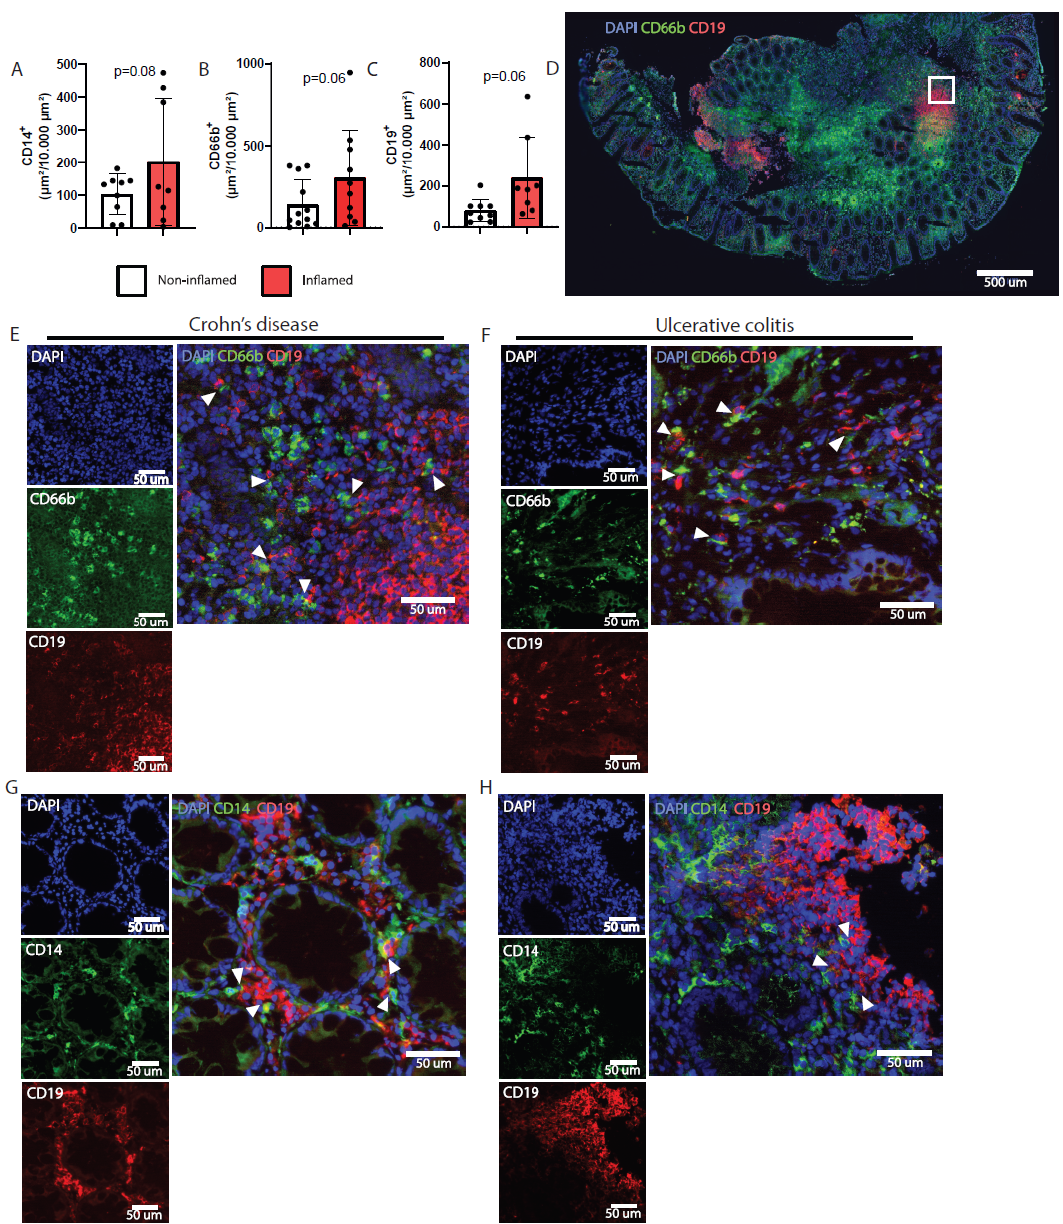
Figure 1. Myeloid cells interact with B lymphocytes in the inflamed colon tissue of inflammatory bowel disease patients. Tissue was collected from either inflamed pathological regions or adjacent macroscopic nonpathological parts of the colon of inflammatory bowel disease (IBD) patients. ( A ) Quantification of the number of monocytes (identified as CD14 + ), ( B ) neutrophils (identified by anti-CD66 + ), and ( C ) B lymphocytes (identified as CD19 + ) in IBD patient biopsies from inflamed (red) or noninflamed (white) regions of the colon. ( D ) Example image for DNA (DAPI, blue), CD66b + cells (green), and B lymphocytes (CD19, red) in inflamed colon biopsy of Crohn’s disease patient. Magnification (white square) was used for ( E ). ( E , F ) Single staining of DNA, CD66b + neutrophils, and CD19 + cells of ( E ) Crohn’s disease (representative sample out of n = 5) and ( F ) ulcerative colitis (representative sample out of n = 3). Merged channels visualize the interaction (white arrows) between CD66b + cells and CD19 + B lymphocytes. ( G , H ) Visualization for DNA, CD14 + monocytes (green), and CD19 + B lymphocytes in inflamed colon biopsy of patients with ( G ) Crohn’s disease ( n = 5) or ( H ) ulcerative colitis ( n = 3). Merged channels are demonstrated to visualize the interaction (white arrows) between CD14 + cells and B lymphocytes.